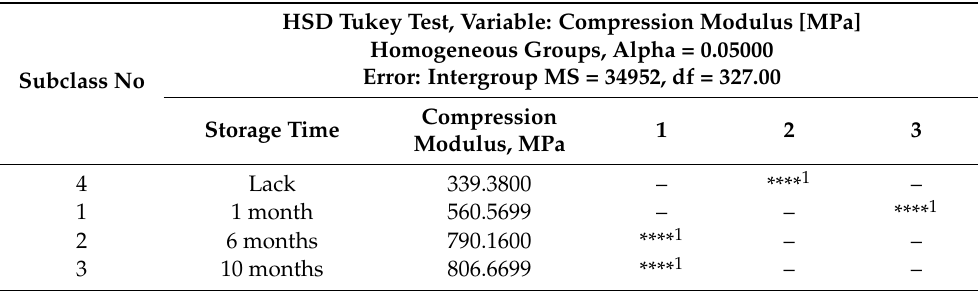
Table 5. Homogeneous groups isolated in the Tukey post-hoc test for aging duration.